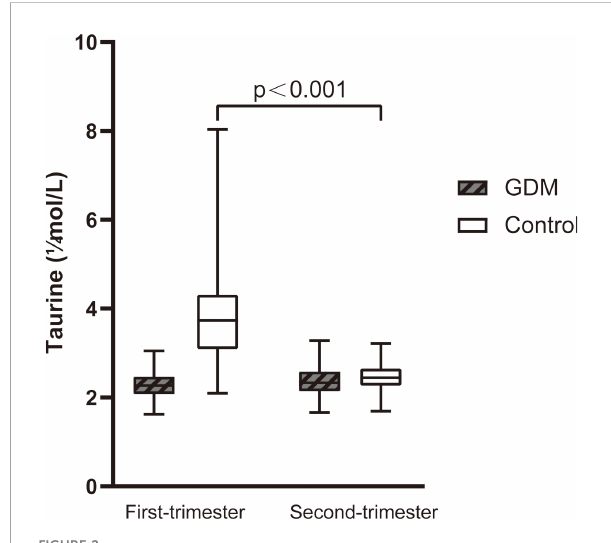
FIGURE 2 The dynamic changes of serum taurine between the fi rst and second trimester of women with GDM and controls. Serum taurine concentration in control decreased signi fi cantly